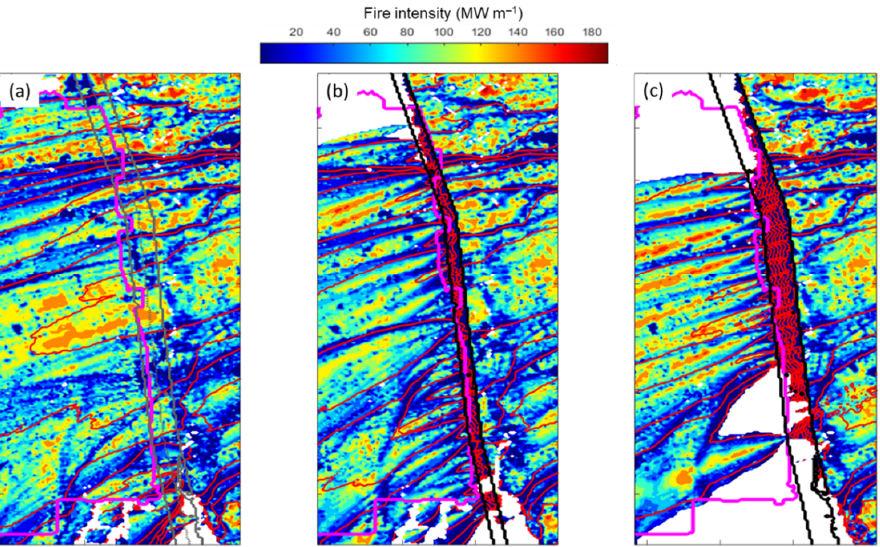
Figure 5. Simulated fire intensity of the 2018 Camp Fire for the: ( a ) no WUI-FB; ( b ) WUI-FB200; and ( c ) WUI-FB400 scenarios. Red contours indicate fire propagations and thick magenta lines indicate the Paradise Township boundary. The locations of the WUI fuel break are indicated by a black polygon. The WUI fuel break location shown in ( a ) is only for reference.